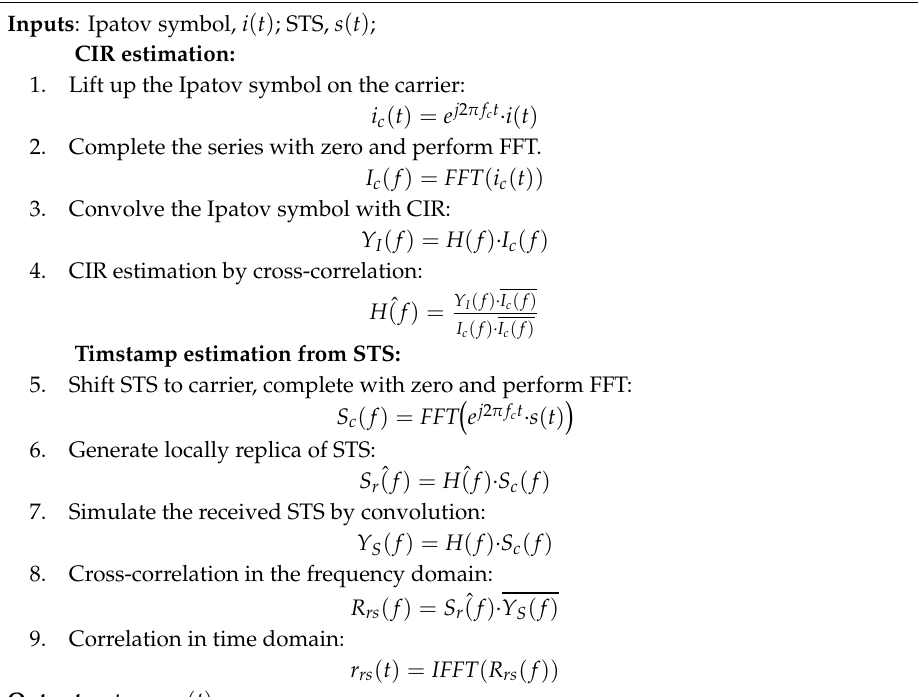
Algorithm 3 : Timestamp estimation in channel with frequency selective